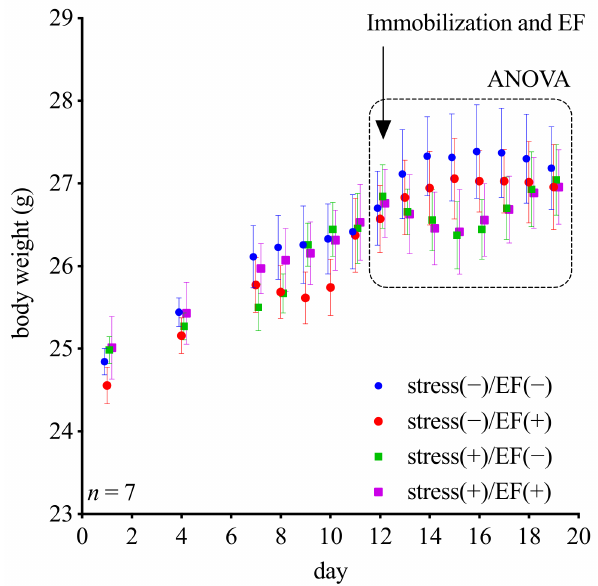
Figure 8. Changes in bodyweight, Experiment 4. The body weights of mice in the control group increased during the 19-day testing period. Those of mice in the immobilization-alone and co- treatment groups decreased for three days after immobilization occurred on the 12th day. For days 12 to 19 (see dashed box), two-way ANOVA (stress ( − )/EF ( − ), stress ( − )/EF (+), stress (+)/EF ( − ), and stress (+)/EF (+)) was performed. For the main effect, “treatment”, F (DFn, DFd) = F (3, 24) = 0.3280, the p -value is 0.8051; and “day”, F (DFn, DFd) = F (3.592, 86.20) = 5.567, the p -value = 0.0008, for the interaction between treatment and day, F (DFn, DFd) = F (21, 168) = 3.921, the p -value <